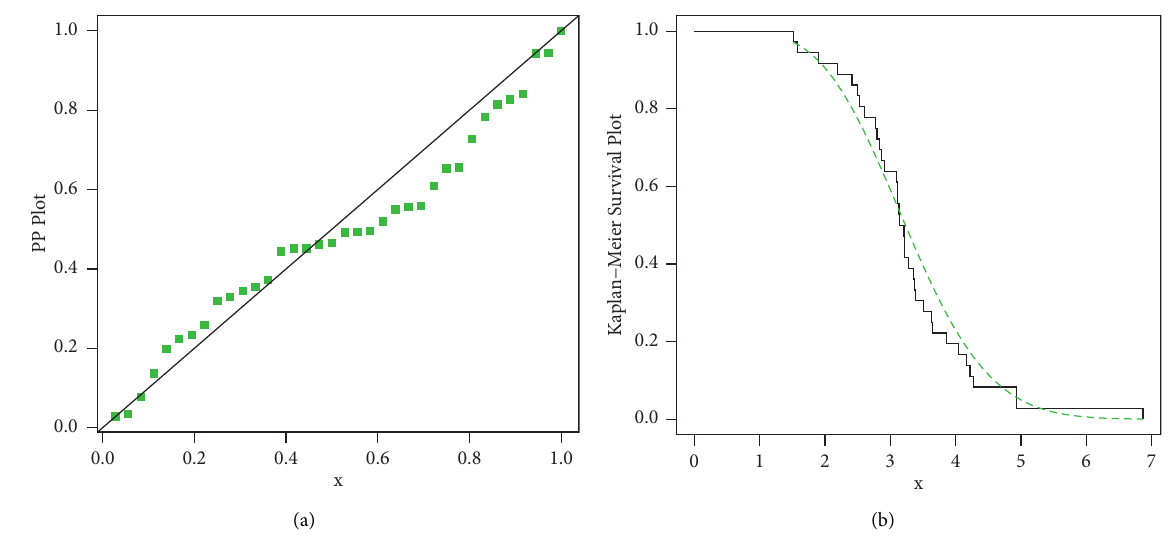
Figure 6: PP and Kaplan–Meier survival plots for the proposed model using COVID-19 data collected in